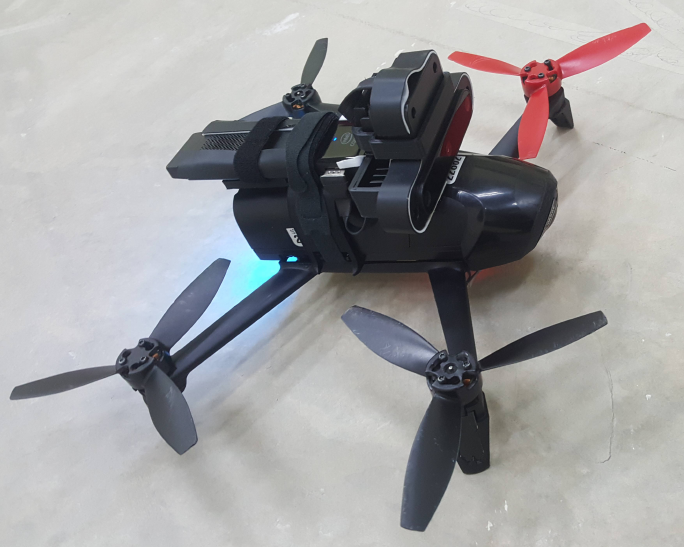
Figure 3. First mount design enabling the Bebop 2.0 Power Edition to carry the Intel Compute Stick and the OAK-D smart camera with its original case. In this design, the total weight was 283 g, 117 g for the OAK-D sensor, plus 166 g for the onboard computer and the mount. This exceeds the maximum payload set by us (200 g) by 83 g, which resulted in unstable